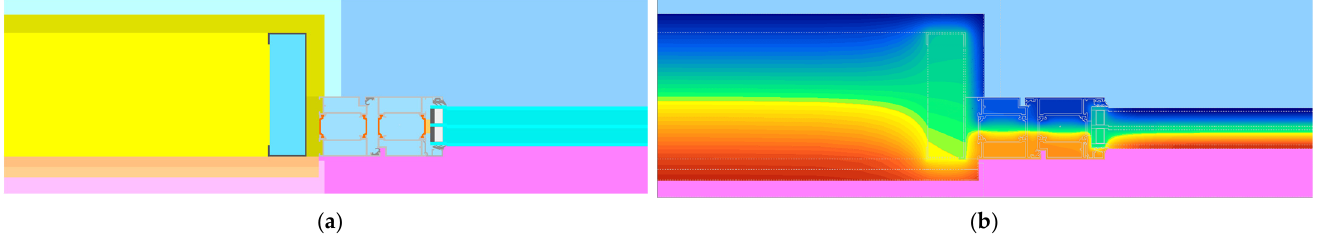
Figure A4. Exterior wall-window horizontal connection: ( a ) Geometrical models; ( b ) Isothermal sur- faces.